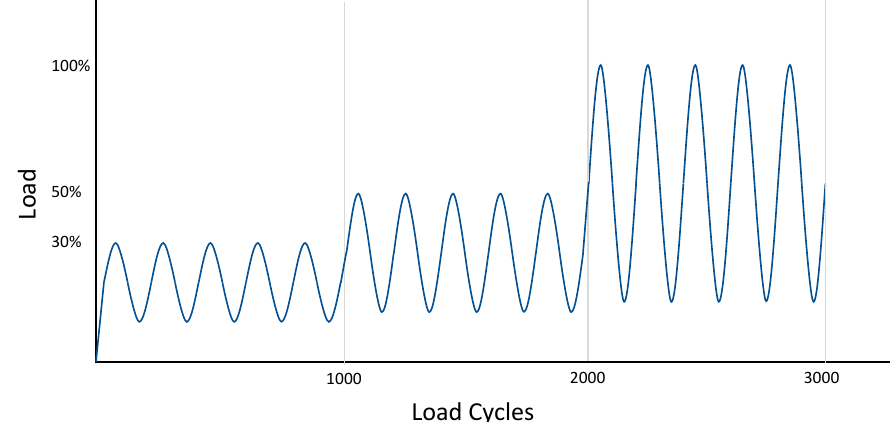
Figure 2. Schematic graph displaying the load applied for each sample over the 3000 test cycles.